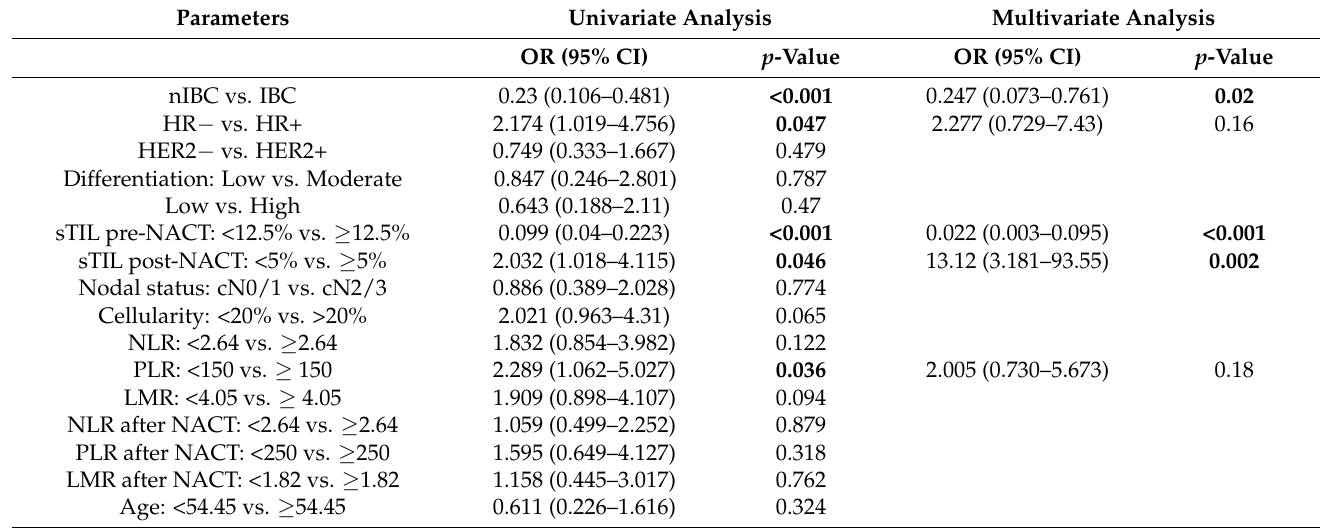
Table 4. Uni- and multivariate analysis for decrease of sTIL after NACT (< − 2.5%). nIBC: non-inflammatory breast cancer, IBC: inflammatory breast cancer, HR: hormone receptor status, sTIL: stromal tumour infiltrating lymphocytes, NACT: neo-adjuvant chemotherapy. RD: residual disease, NLR: neutrophil-lymphocyte ratio, PLR: platelet-lymphocyte ratio, LMR: lymphocyte-monocyte ratio and, sTIL: stromal tumour infiltrating lymphocytes, NACT: neo-adjuvant chemotherapy. Bold values denote statistical significance at the p < 0.05